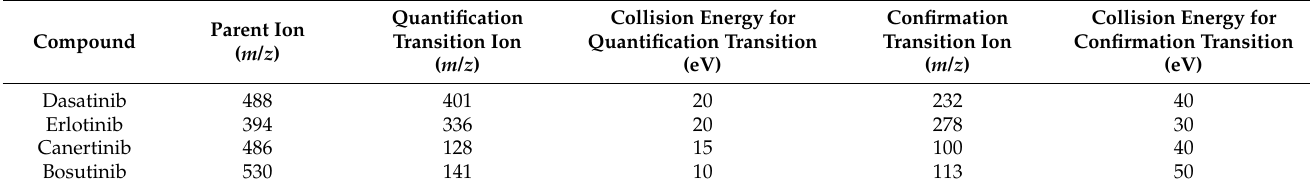
Table 1. SRM transitions of model